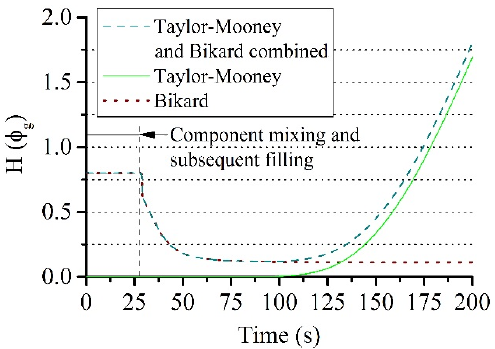
Figure 8. Influence of the gas fraction on the mixture viscosity with the function of Equation (10).